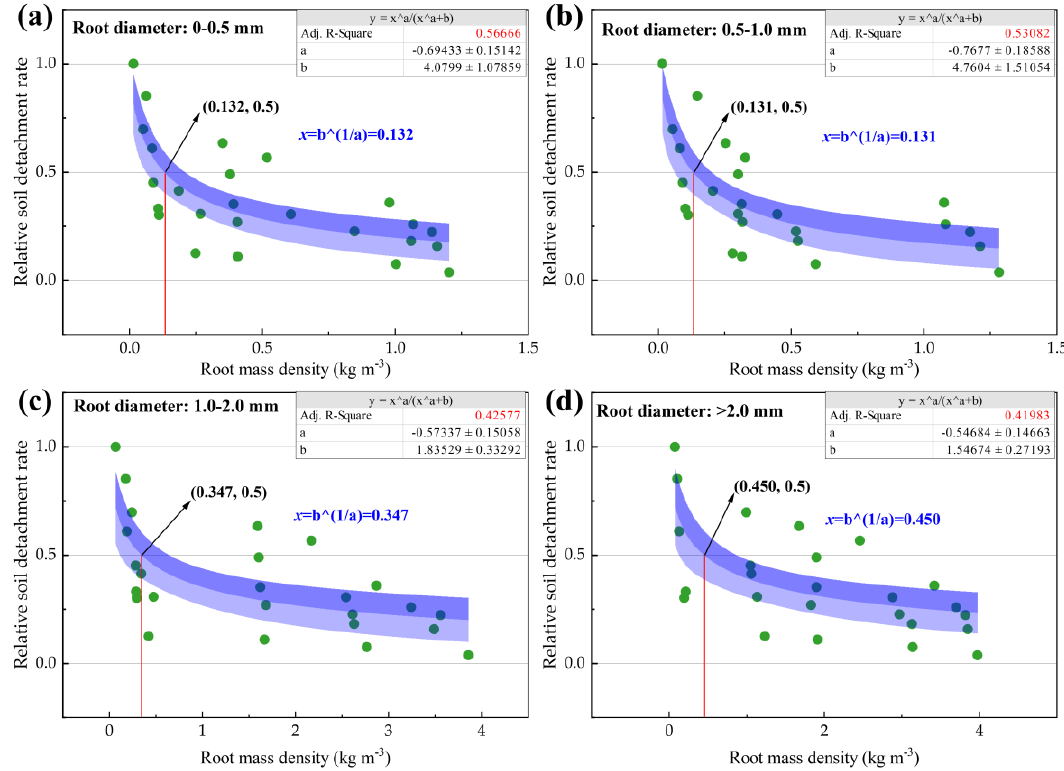
Figure 8. Relationships between relative soil detachment rate and root mass density of different root diameters. ( a ) Root of 0–0.5 mm; ( b ) Root of 0.5–1.0 mm; ( c ) Root of 1.0–2.0 mm; ( d ) Root > 2.0 mm.